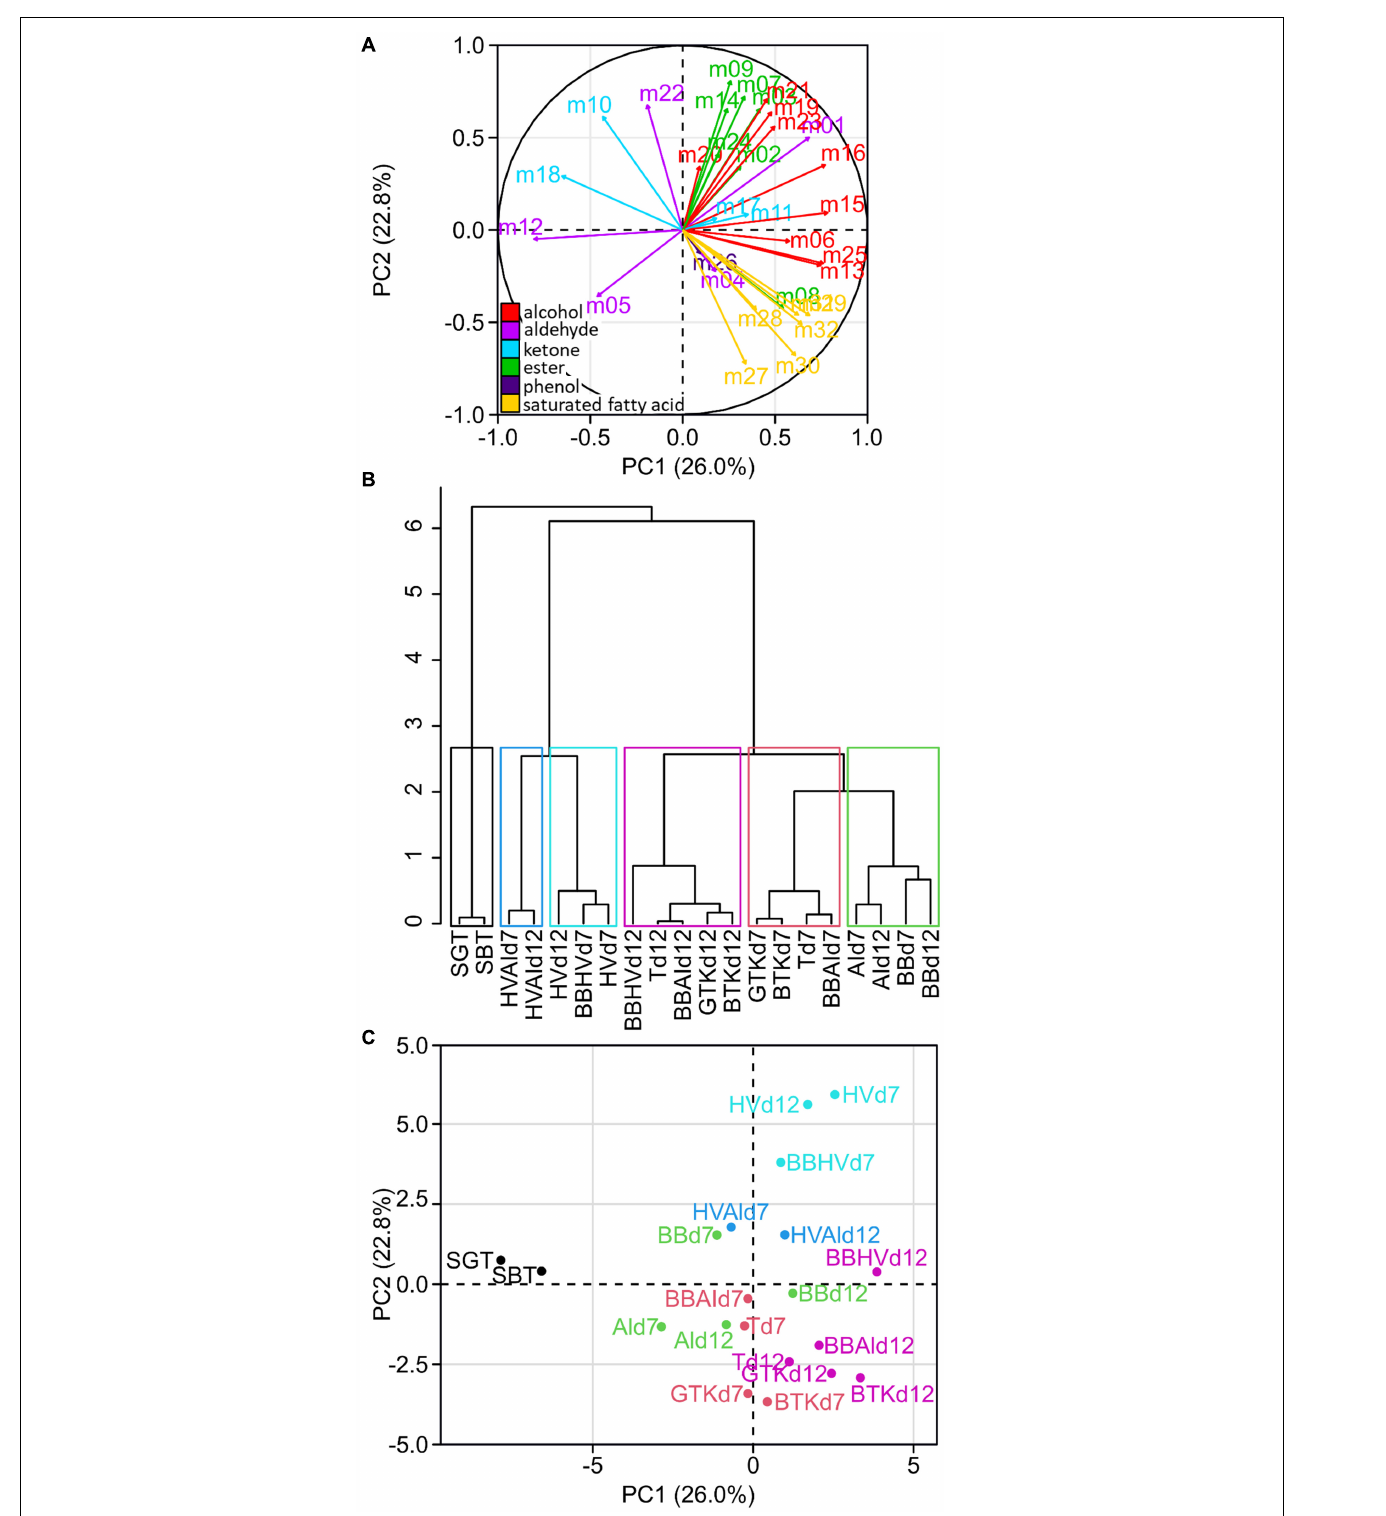
FIGURE 1 | Unsupervised classification using principal component analysis (PCA) and hierarchical clustering (HCA) on the relative concentration of the 32 metabolites from the 18 cultures ( n = 3). Loading plot (A) shows the projection of each metabolite numbered consistently with Table 2 . The metabolite coloration corresponds to its chemical family: alcohol (red), aldehyde (magenta), ketone (blue), ester (green), phenol (purple) and saturated fatty acid (yellow). HCA (B) with cut-off enabling a separation in six clusters depicted in the PCA score plot (C) with each cluster associated to one color.